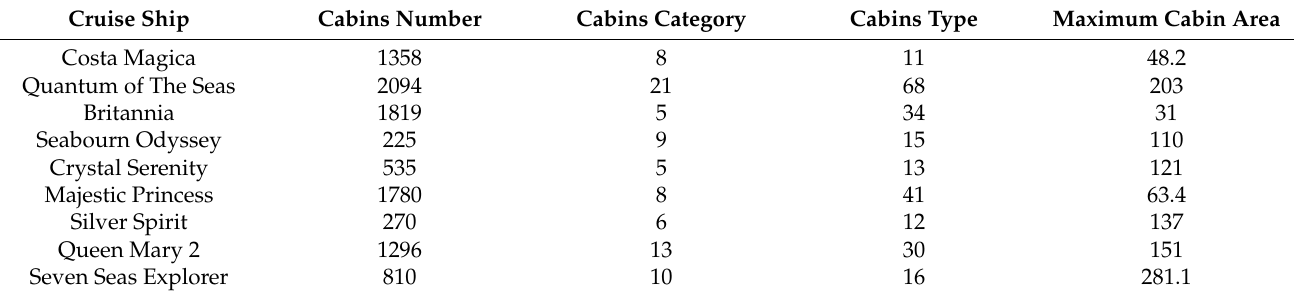
Table 6. The accommodation condition of cruise ships.